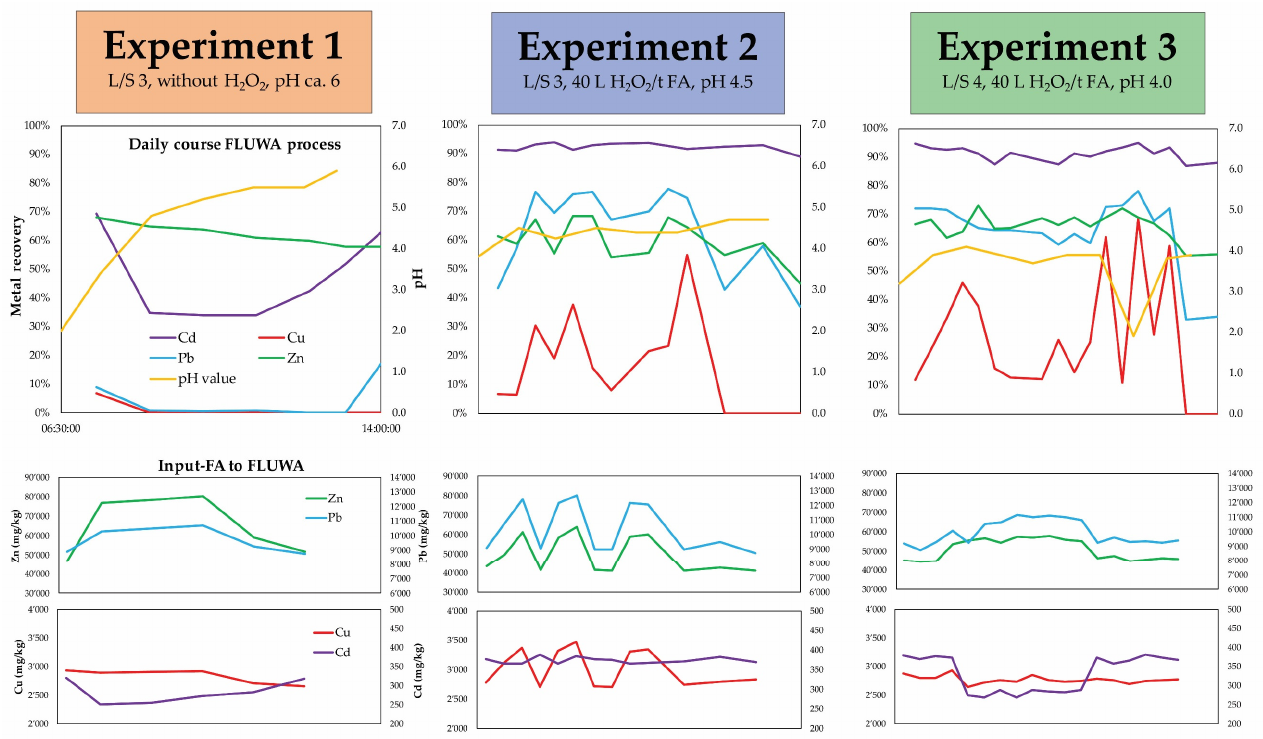
Figure 3. Results of the daily course of the three industrial-scale experiments of the FLUWA process at MSWI plant Linth. The concentrations in the input-FA (mg/kg) and the recoveries (%) of the metals Zn, Pb, Cu and Cd as well as the pH value at the end of the process are shown for each experimental day.